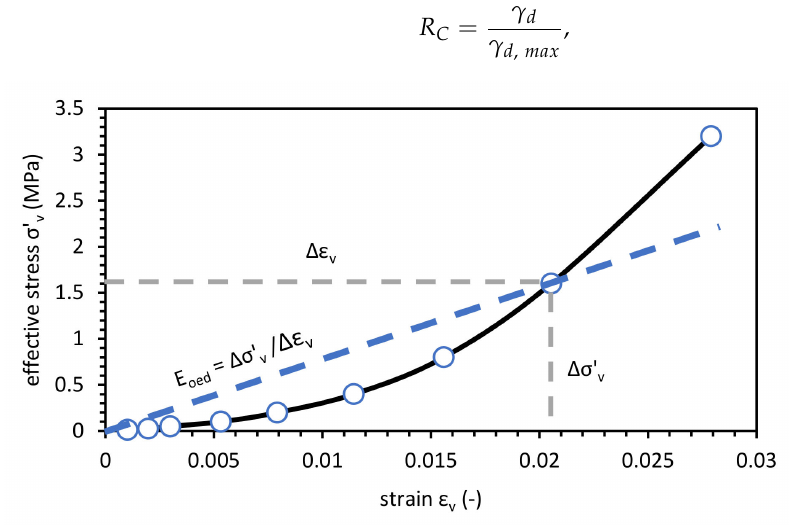
Figure 1. Secant modulus evaluation technique from oedometric tests on AM in fived effective vertical stress